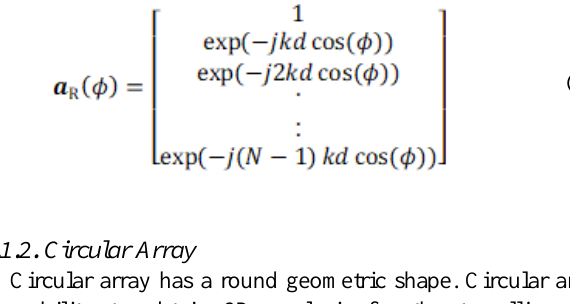
Circular array has a round geometric shape. Circular array has ability to obtain 3D analysis for the travelling and incoming, Direction-of-Departure (DoD) or Direction-of- Arrival (DoA), respectively [21].